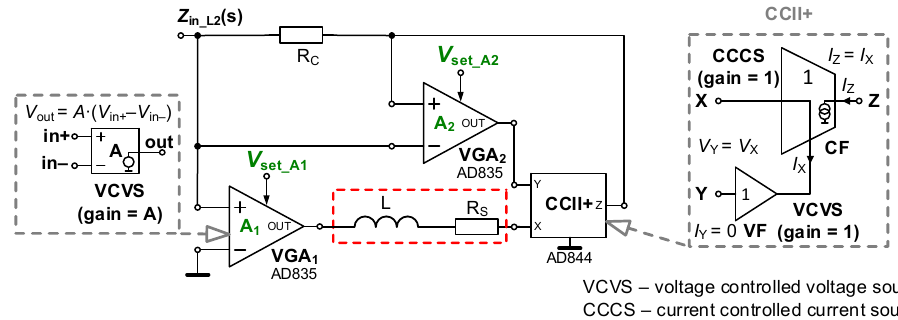
Figure 2. Topology of electronically adjustable inductance using VGA and CCII+ suitable for R S cancellation.